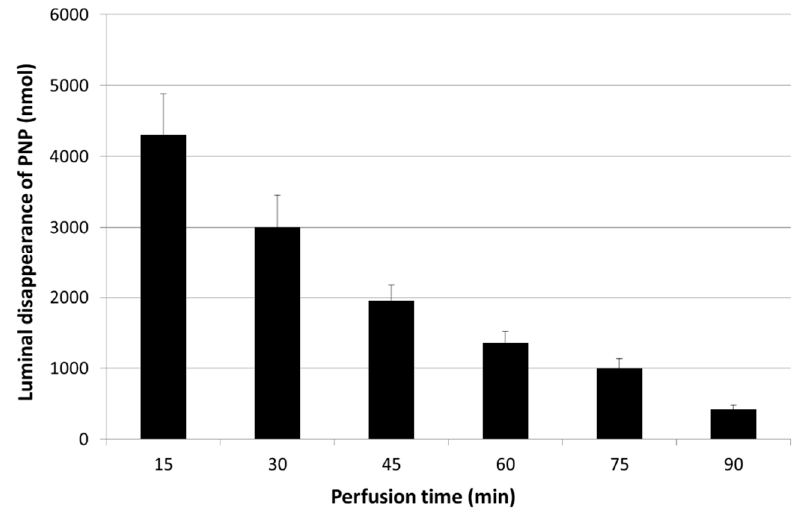
Figure 1. Luminal disappearance of p -nitrophenol (PNP) from the small intestine (proximal jejunum) measured in 90 min perfusion of 500 µM PNP. Values represent the mean ± S.D. of eight rats.